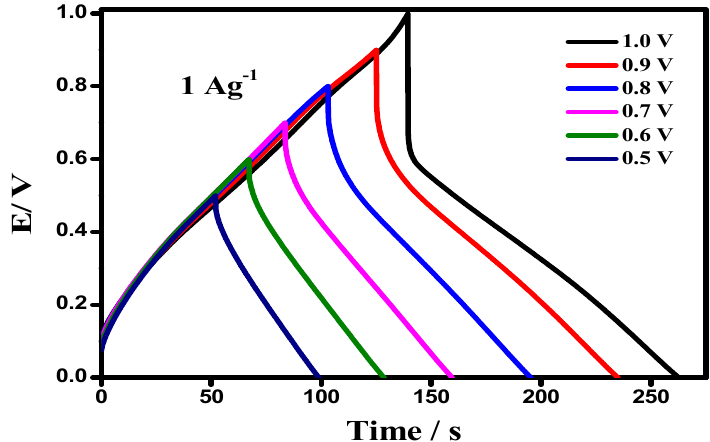
Figure 10. GCD of a device with varying potential, from 0.0 V to 1.0 V, at an interval of 0.1 V.